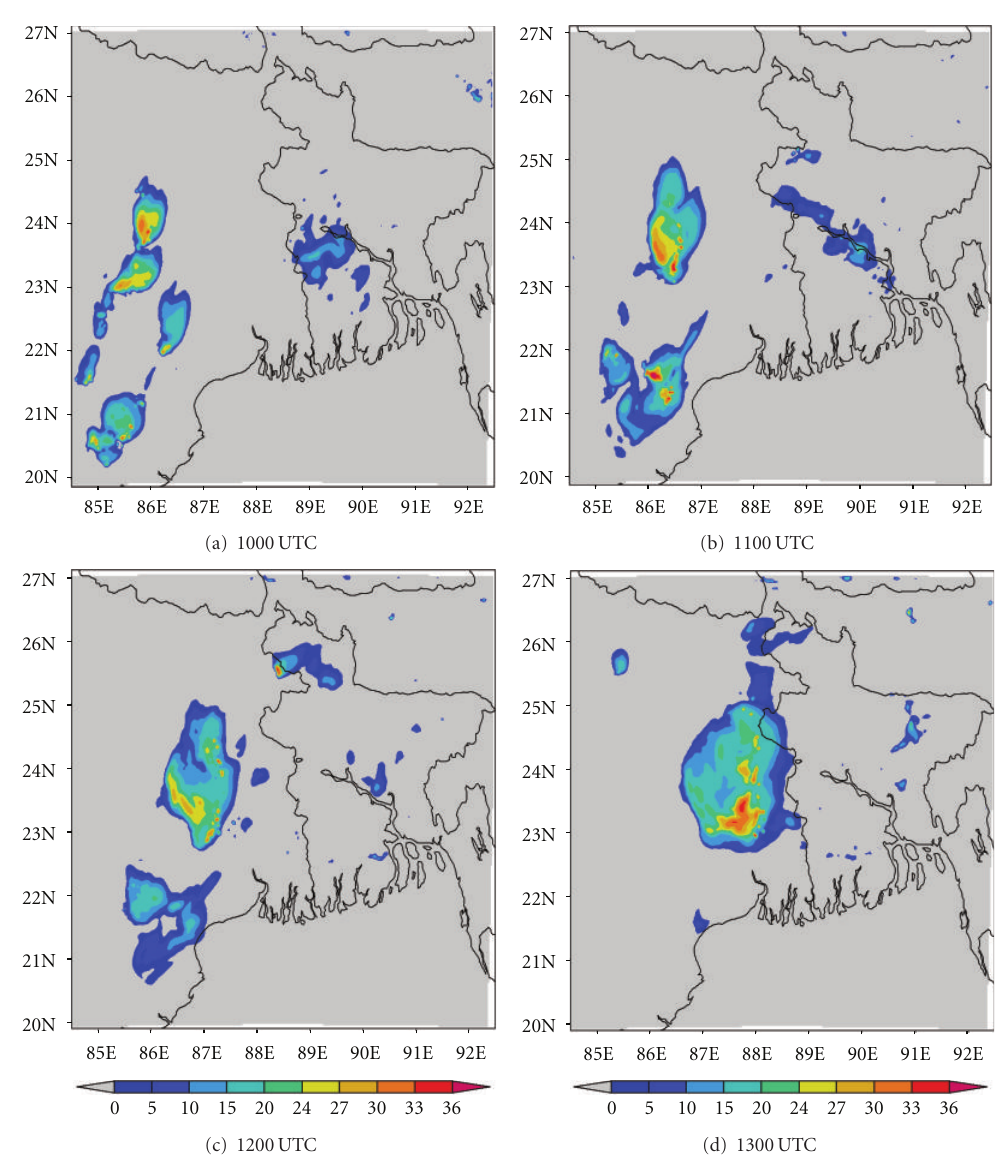
Figure 5: NMM-simulated composite radar reflectivity (dBZ) pictures from 1000 to 1300 UTC on 03, May,